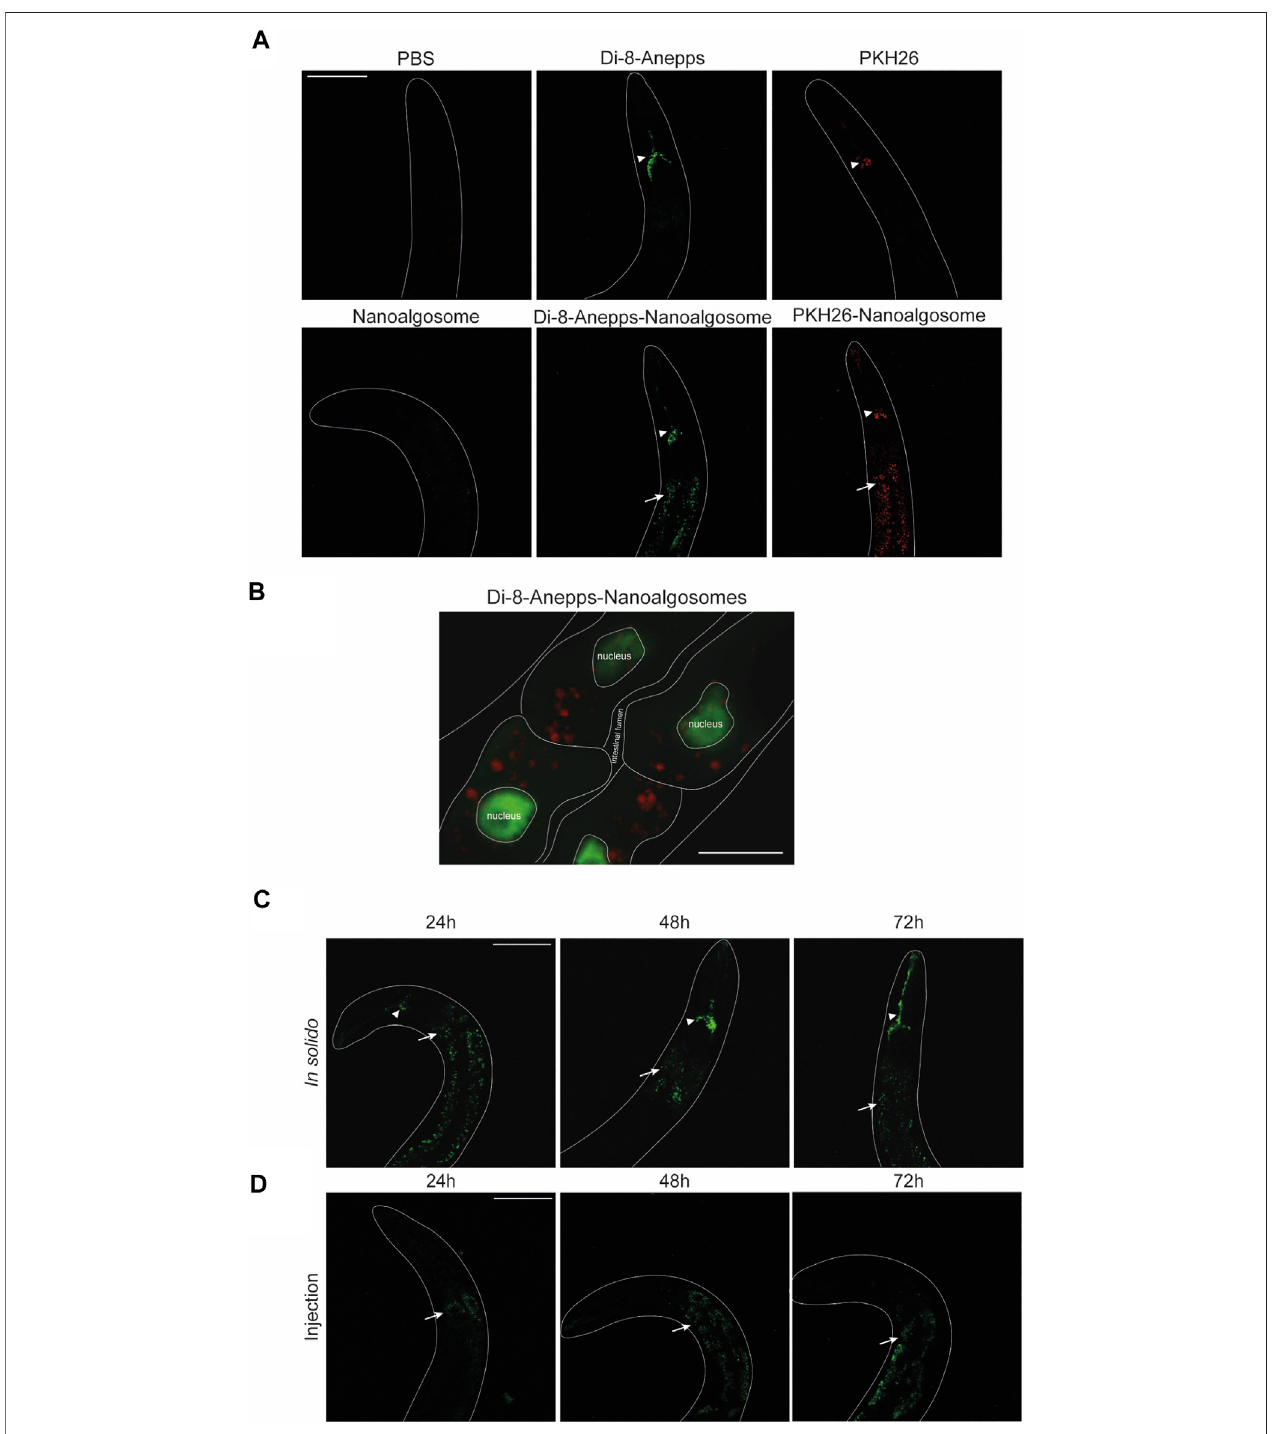
FIGURE 5 | C elegans intestinal cells uptake and persistence of labelled nanoalgosomes. (A) Confocal images of animals treated with PBS, Di-8-Anepps free dye, PKH26 free dye for 24 h are shown in the upper panels; animals treated for 24 h with unstained nanoalgosomes, Di-8-Anepps-nanoalgosomes and PKH26-nanoalgosomes are shown in the lower panels. A fl uorescent signal was observed in animals treated with labelled nanoalgosomes in the intestinal cells (arrows) and in the head (arrowheads). Anterior is up. Scale bar 75 µm. (B) Localisation of Di-8-Anepps-nanoalgosomes in the cytoplasm of intestinal cells expressingGFP inthenucleithanksto elt-2 promoter.TheDi-8-Anepps-nanoalgosomesspeci fi csignalhasbeen pseudo-colored in red. Scalebar 25 µm. (C,D) The persistence of the fl uorescent signal (arrows) was assessed in animals treated with Di-8-Anepps-nanoalgosomes for 24, 48 and 72 h after treatments in solido (C) or injection (D) . A fl uorescent signal in the head (arrowheads) is also visible in solido. Anterior is up. Scale bar 75 µm.